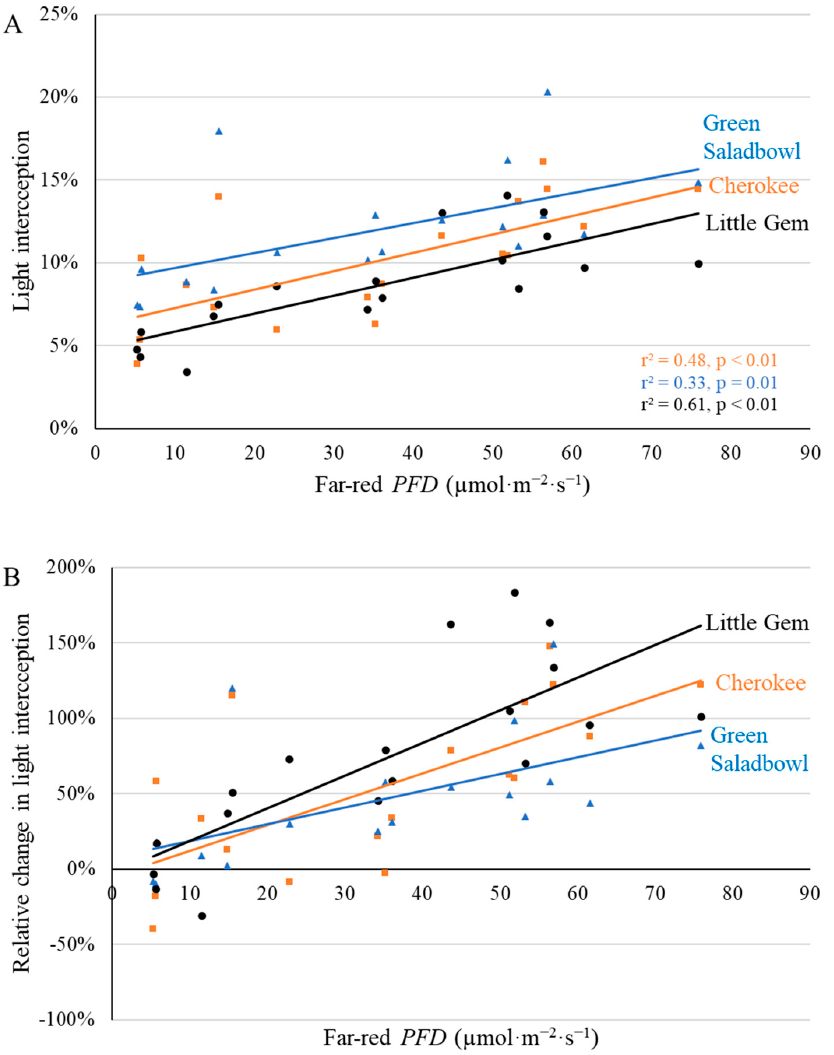
Figure 3. With a background of 204 µ mol · m − 2 · s − 1 white LED light, supplemental far-red photons linearly increased canopy light interception ( A ) and the relative change in canopy light interception (( B ), compared to plants under no supplemental far-red light) 9 days after the start of far-red light treatment for ‘Cherokee’, ‘Green Saladbowl’, and ‘Little Gem’ lettuce. The r 2 and p values for regression of each cultivar apply to both graphs and are shown with the respective